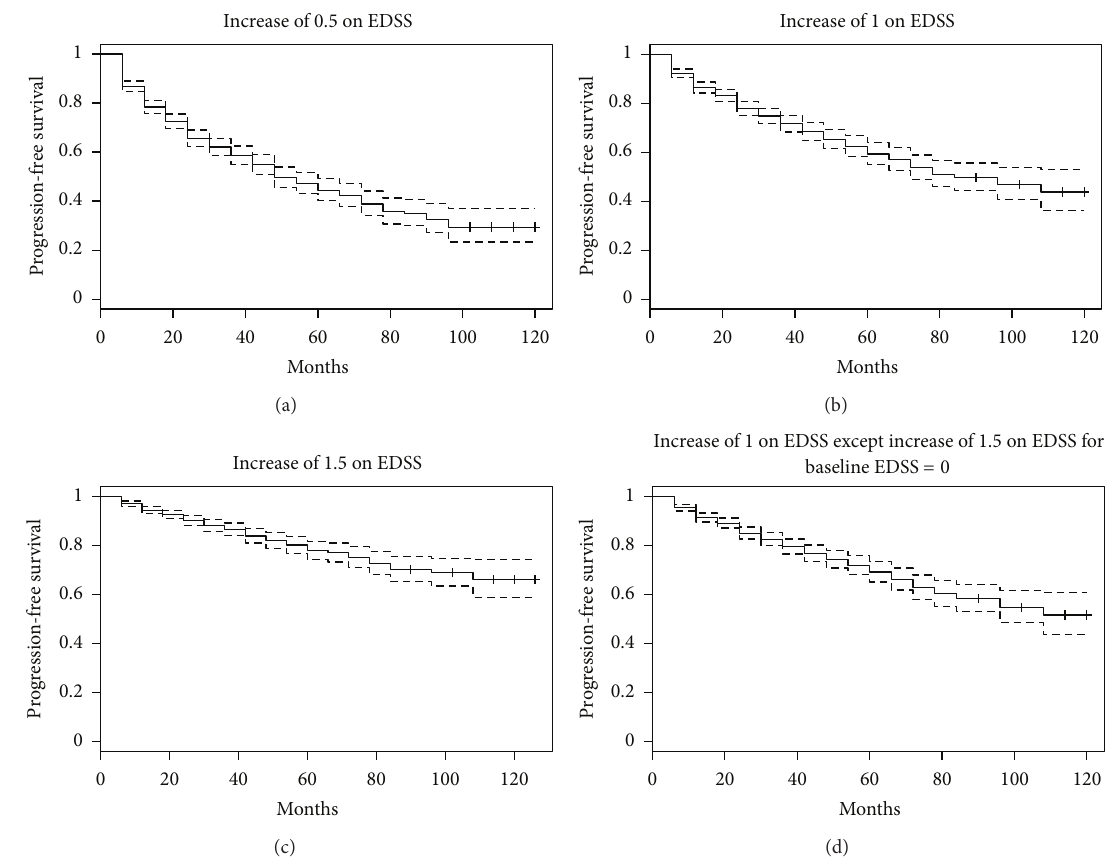
Figure 2: Time to sustained progression for EDSS definitions. EDSS: expanded disability status scale. Each Kaplan-Meier plot presents the time to sustained progression using a specific definition: (a) top left: increase of 0.5 on the EDSS sustained for two visits (D1); (b) top right: increase of 1 on the EDSS sustained for two visits (D2); (c) bottom left: increase of 1.5 on the EDSS sustained for two visits (D3); (d) bottom right: increase of 1.5 for baseline EDSS = 0 and increase of 1 for baseline EDSS ≥ 1 sustained for two visits